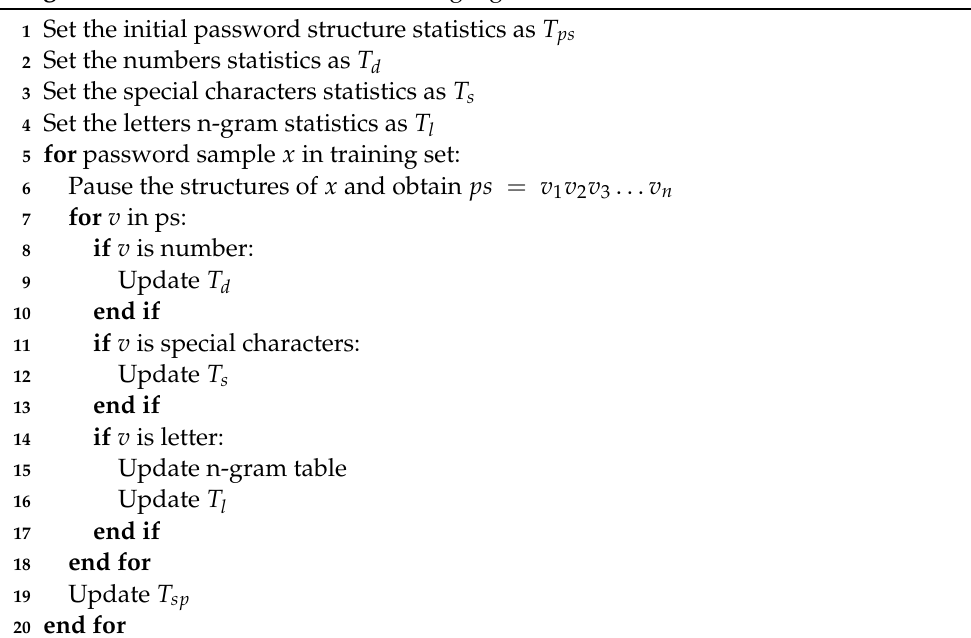
Algorithm 1: LPG–PCFG model training